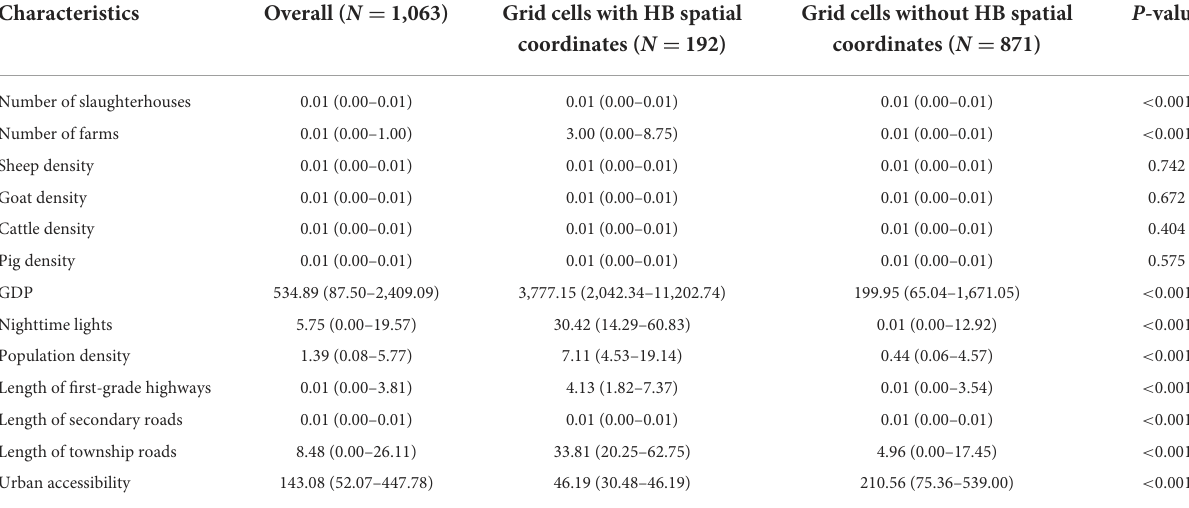
TABLE 3 Geographic heterogeneity of socioeconomic factors for grid cells, with and without HB spatial coordinates. Characteristics